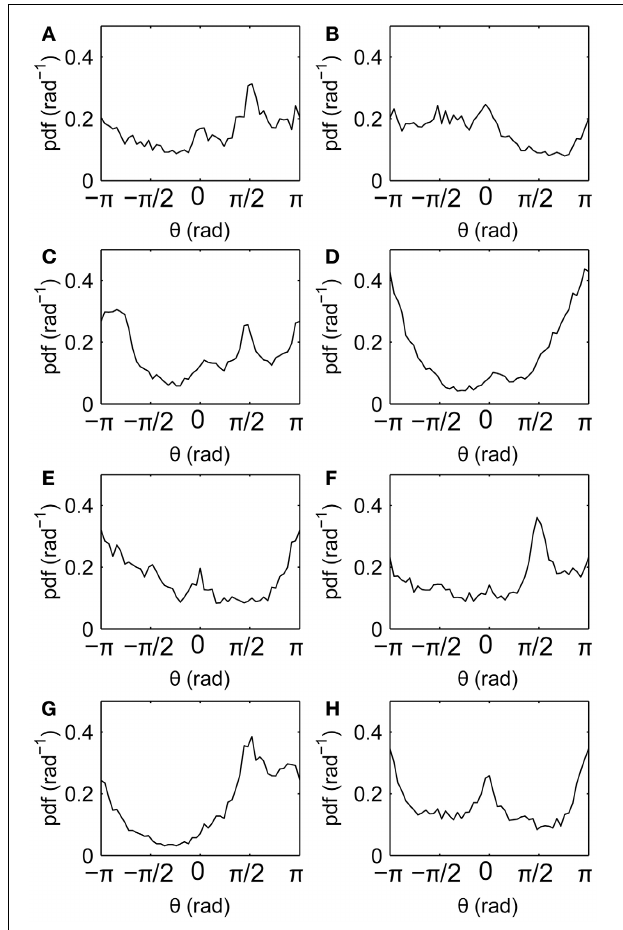
FIGURE 6 | Fixation drift directions relative to the screen. (A–H) Subjects 1–8, respectively, showing distributions of fixation drift angles θ , where θ = 0 , ± π denotes horizontal drifts and θ = ± π / 2 denotes vertical drifts.